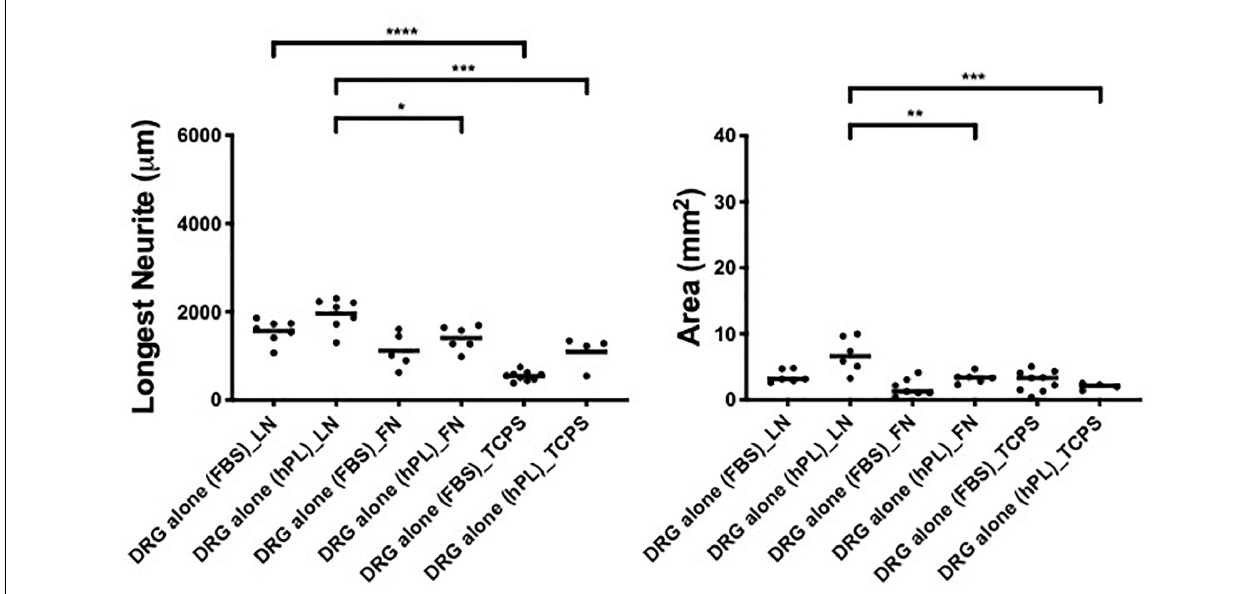
FIGURE 2 | Serum additives significantly influence DRG neurite outgrowth, but only in combination with laminin (condition 1—DRG alone). Longest neurite and axonal area of DRG alone on the extracellular matrix (ECM). Three biological repeats and at least three technical replicates (DRG) were assessed. One-way ANOVA with Tukey’s multiple comparison tests was used for assessing statistical significance among the examined groups (* p < 0.05, ** p < 0.01, *** p < 0.001, **** p < 0.0001). The number of DRG tested corresponds to the number of dots for each condition in the graph.